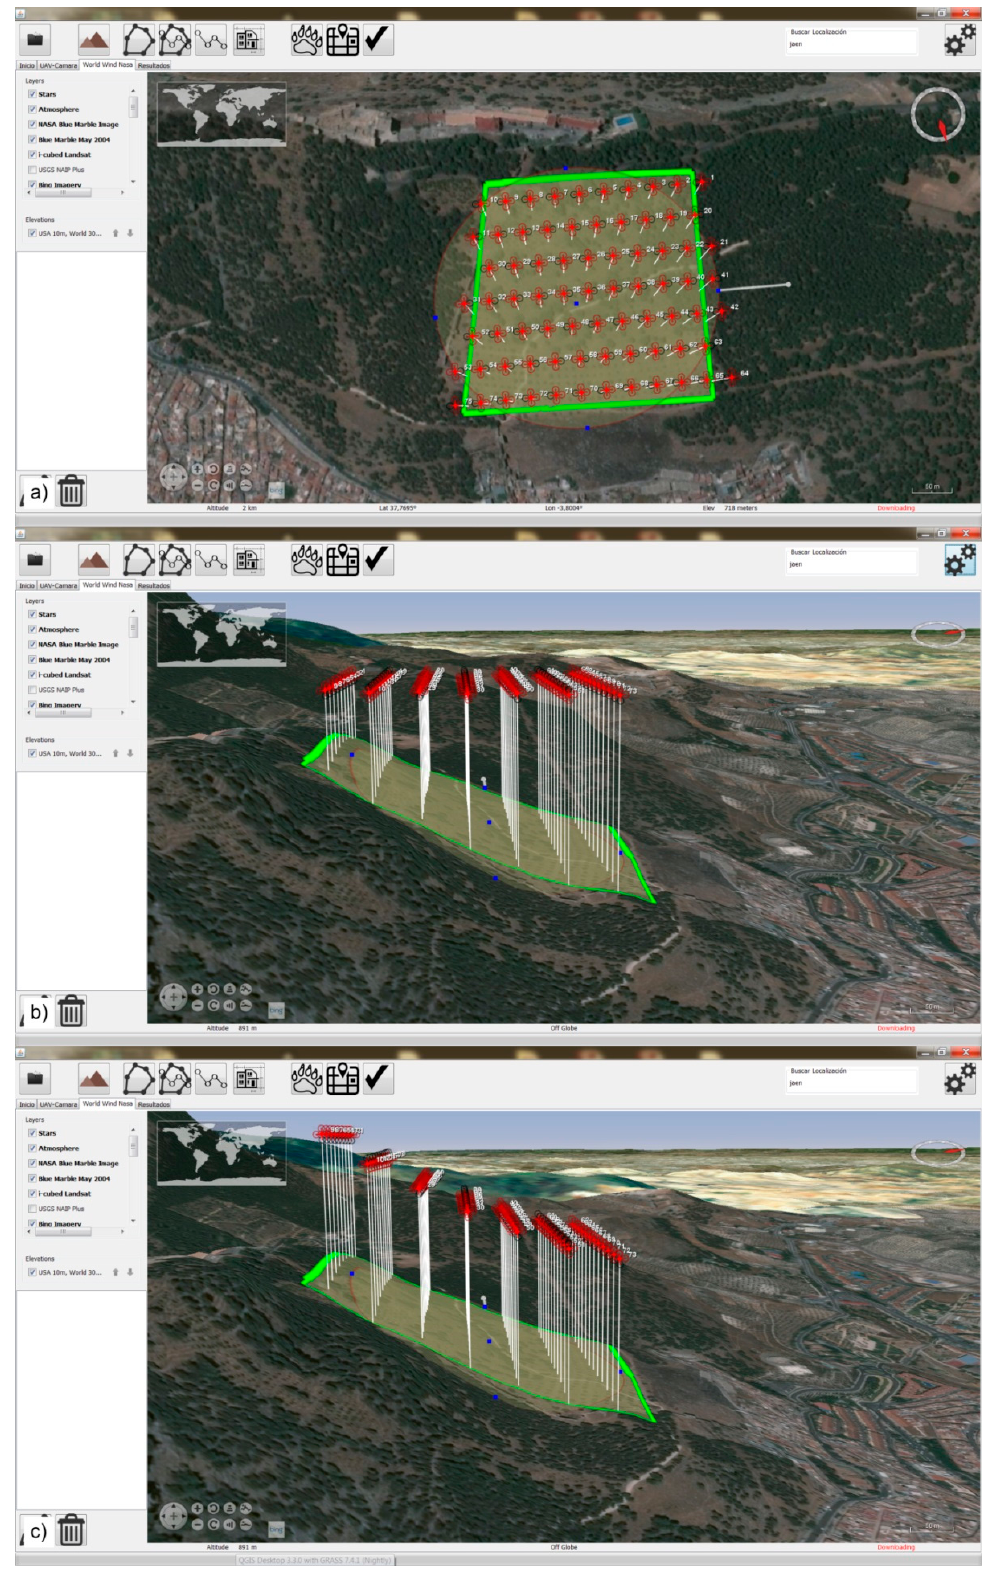
Figure 5. Example of conventional block flight on a sloped zone: ( a ) sloped zone delimited by polygonal line, ( b ) flight planned not considering the DEM, and ( c ) flight planned considering the DEM (with the best estimation of the mean ground sample distance (GSD)).